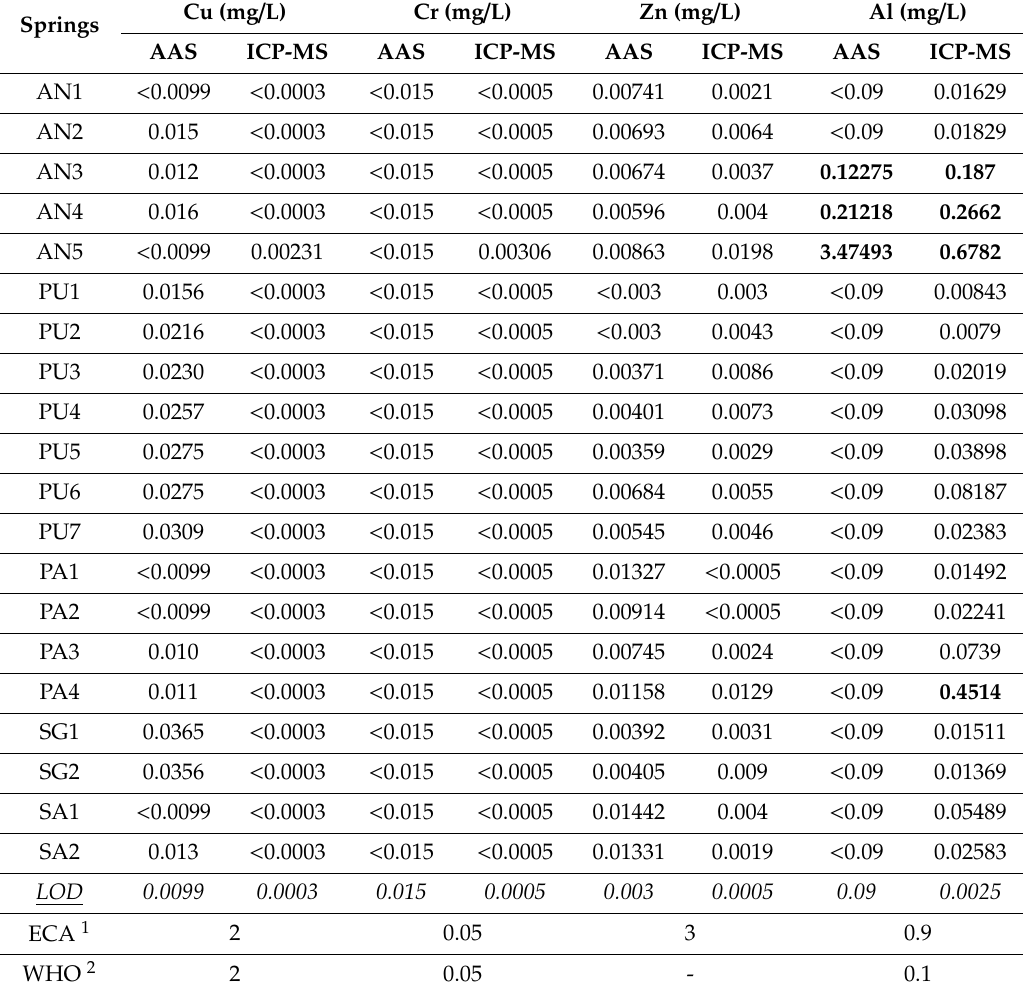
Table 5. Results of the analysis of Cu, Cr, Zn, and Al using two di ff erent techniques (AAS and